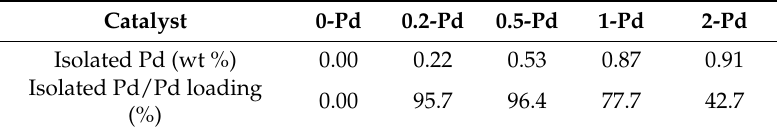
Table 1. The content of Pd ions on exchange sites of each sample.